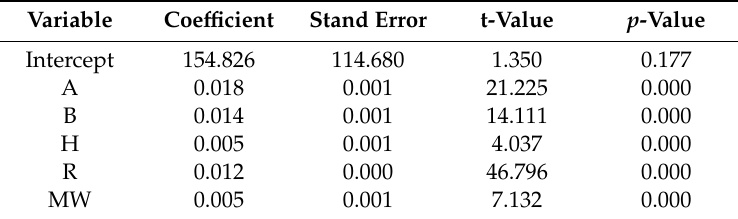
Table 6. Building use regression (BUR) diagnostics 1 .